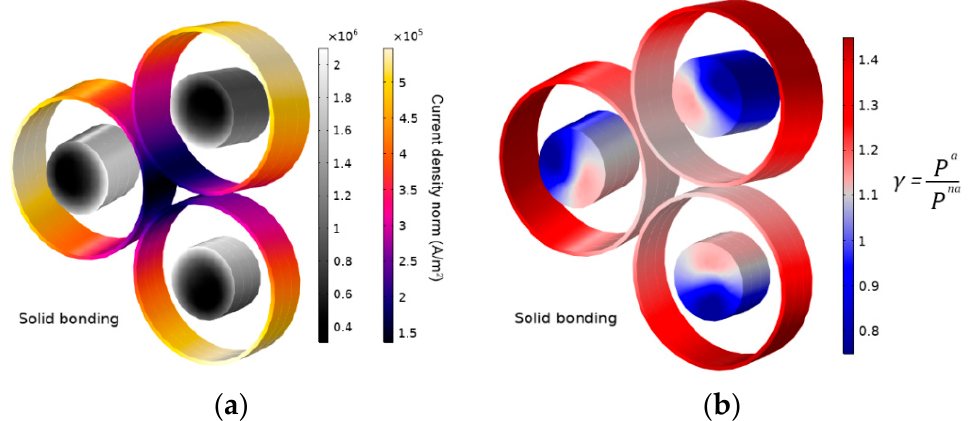
Figure 18. ( a ) Current density and ( b ) variation in the conductors and the sheath losses in Cable 6 when a magnetic armor of µ r = 300 − j 200 is installed (SB).